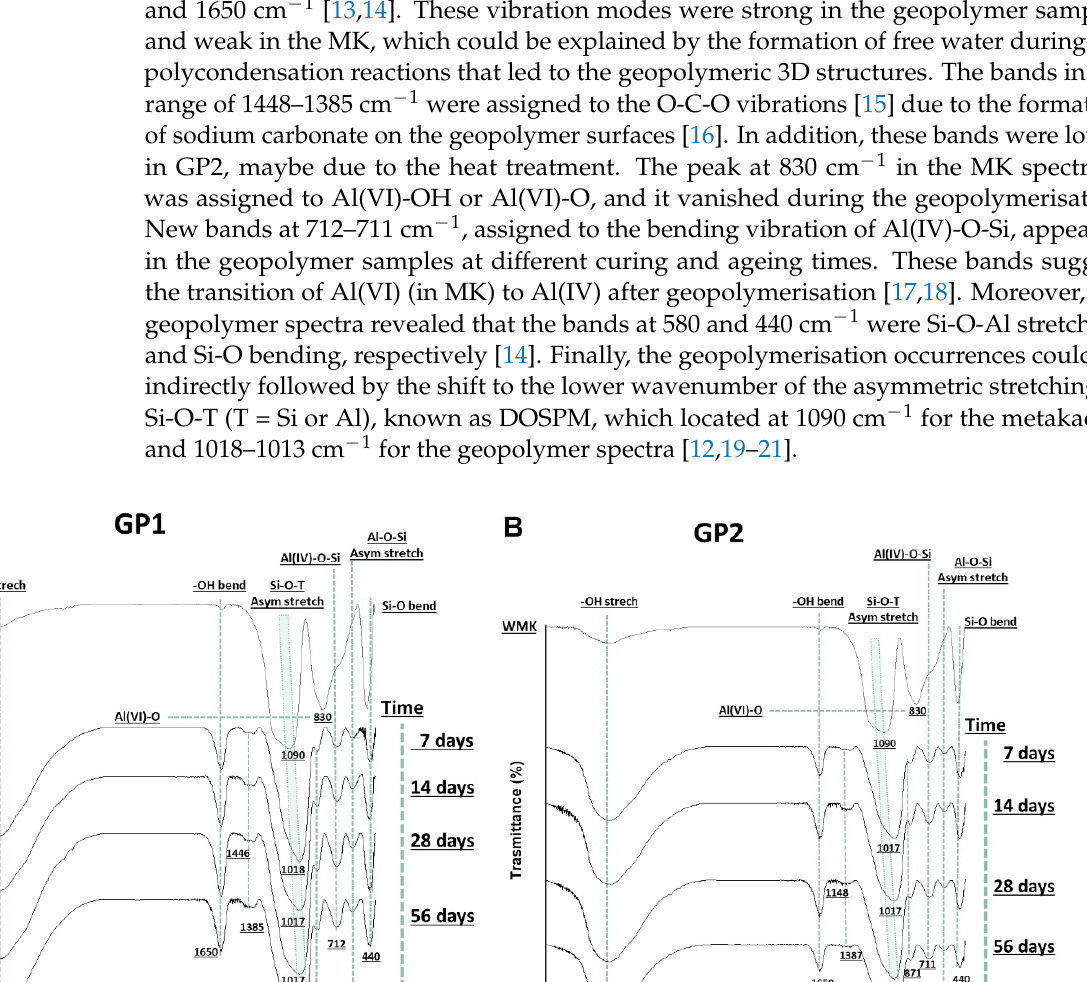
Figure 13. DOSPM of ( A ) MK, GP1, and GP2. ( B ) DOSPM shift from MK recorded at different ageing times. Figure 14A,B report the spectra of the coloured geopolymers. The spectra show that all the samples had geopolymerised; indeed, there were DOSPMs shifts at lower wave- numbers. Moreover, it can be seen that the DOSPM values were very close to those of GP1 and GP2 after 26 days of ageing, suggesting that the synthetic organic dyes incorporated into the geopolymers did not negatively affect the geopolymerisation. We also observed that the amount of organic dyes was so small as not to be detected by this vibrational spectroscopy. A comparison between the sample spectra with and without the dyes (Fig- ures 12 and 14, respectively) shows that there was a little difference due to a sharp absorp- tion band at 420 cm − 1 , visible in the spectra within the dyes.